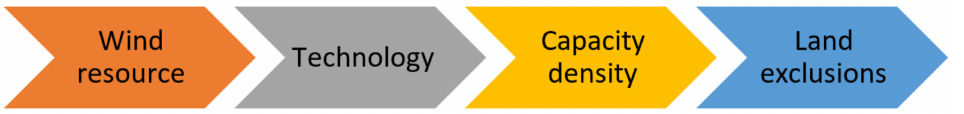
Figure 1. Major components of wind power technical potential. Turbine technology specifications determine the amount of energy that may be captured from the local wind resource.